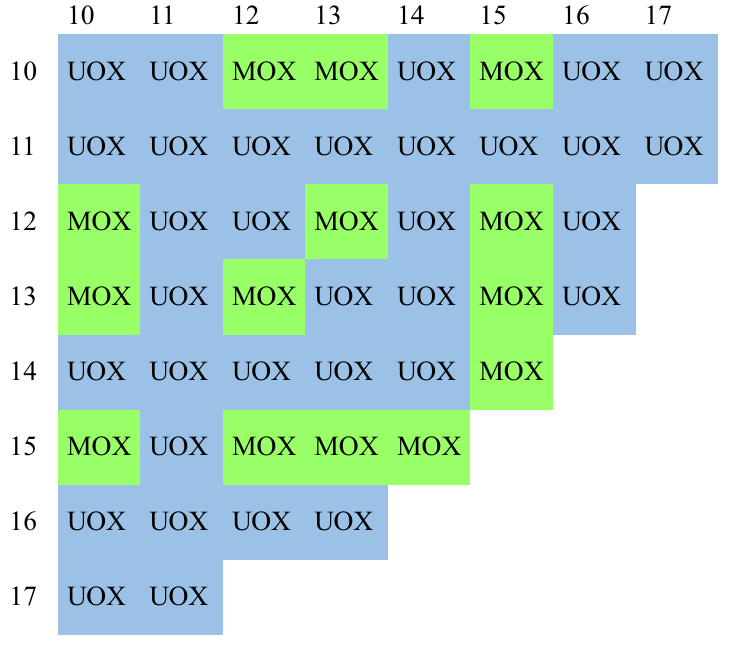
Figure 3. Mixed UOX-MOX core